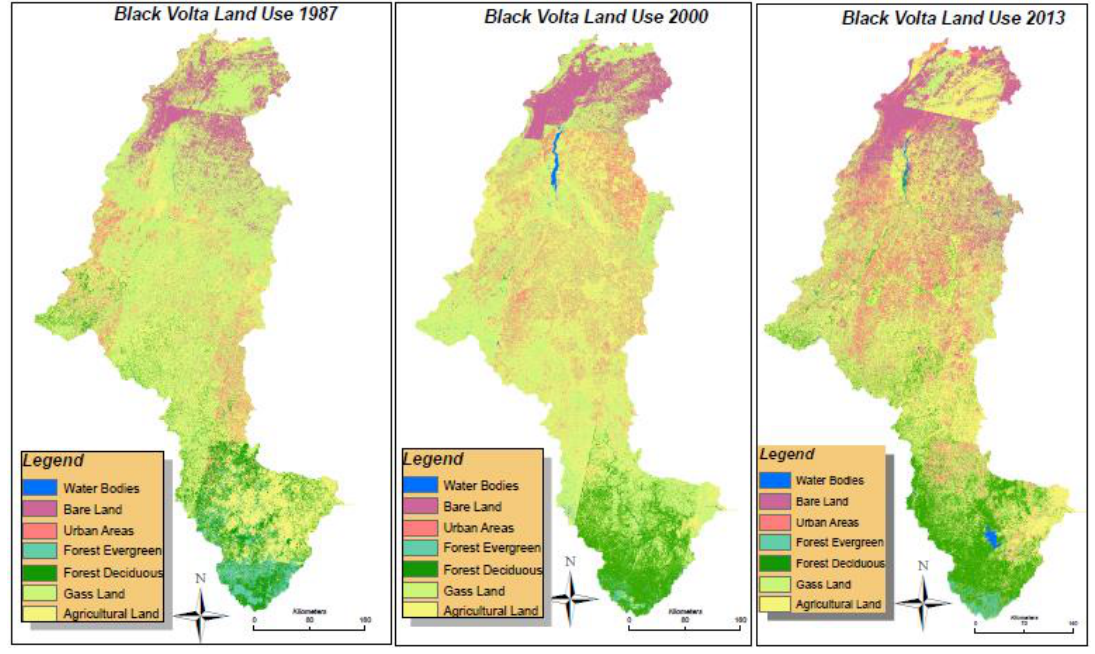
Figure 6. LULC maps of the Black Volta. ( a) LULC 1987; (b ) LLULC 2000; (c) LULC 2013.